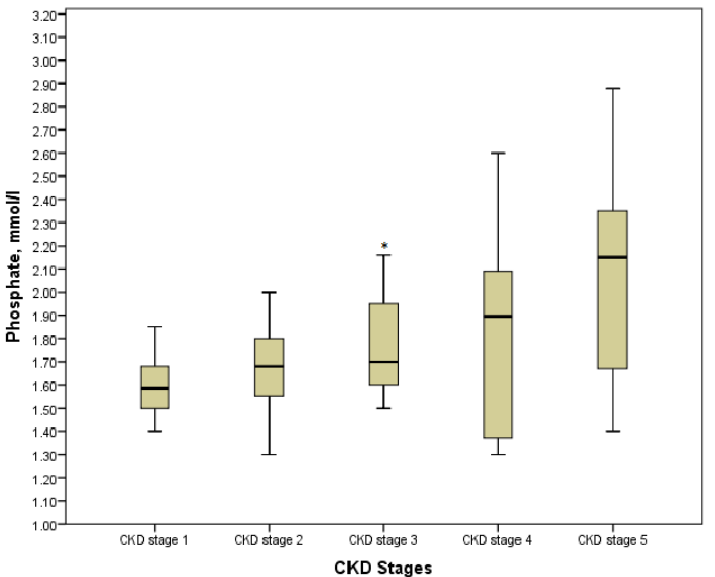
Figure 3. Phosphate level in the various CKD stages. * p = 0.013 CKD stage 3 vs. CKD stage 1. Calcium and ionized calcium levels in serum fluctuated across all stages; however, CKD stage 5 drew attention by the prevalence of significant hypocalcemia. Thus, only 2 children of 17 patients KRT had a normal level of serum calcium. Hyperparathyroidism was present in 30 (41.1%) patients; none of the patients on KRT had the target levels. Even though PTH was strongly positively correlated with stages of the disease ( r = 0.828, p = 0.000), a significant increase was detected only at the pre-dialysis and the last stages of CKD ( p = 0.000) (Figure 4). There were no differences in terms of the type of KRT ( p > 0.05).